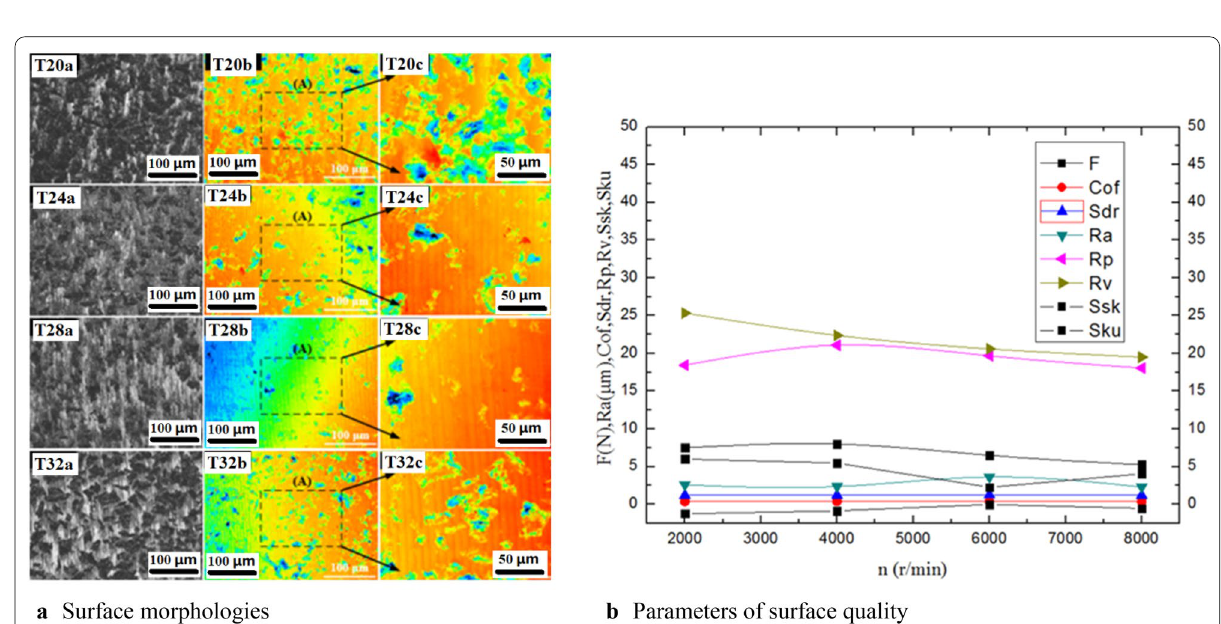
Figure 12 Experimental results of group